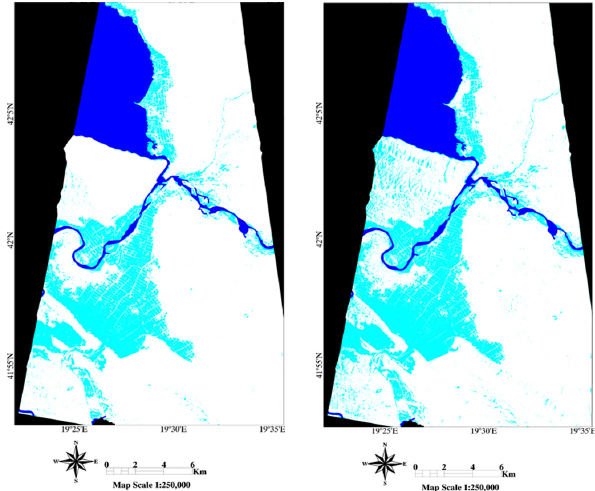
Fig. 5. Map of flooded areas for the Shkod ¨ er flood (10 January 2010). Left panel: map produced by our algorithm; right panel: map produced by a histogram thresholding method. White: non-flooded; cyan: flooded; blue: water bodies according to the land cover map; black: